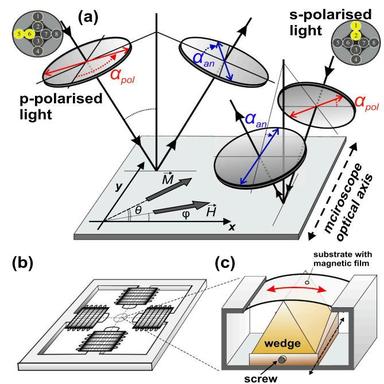
(a) Coordinates used in this paper. Indicated are the directions of the magnetisation vector M ̅→ and the magnetic field vector H →, both measured from the x-axis, as well as the opening angles of polariser and analyser, αpol and αan. By convention, the polariser angle is always measured from the axis transverse to the plane of incidence, whereas the analyser angle is related to the axis parallel to the plane of incidence. In the experiment, the incidence plane is defined by activating proper LEDs as indica